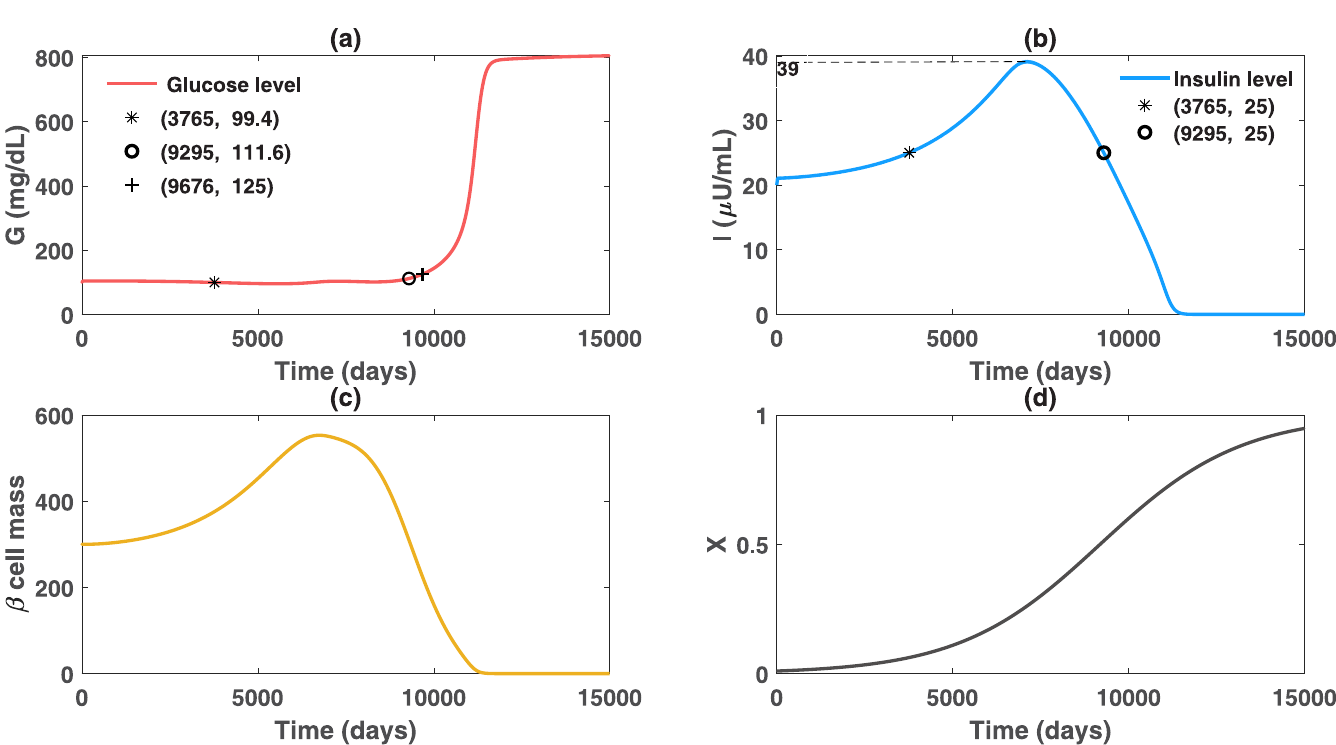
Fig 6. Dynamics of glucose, insulin and functional beta-cell mass for patient B with severe obesity ( X approaches 1 progressively). Patient B is assumed to have a lower insulin resistance level and less beta-cell hyperresponsiveness to the obesity-related factor than patient A does. Graph (b) shows the hyperinsulinemic stage of patient B lasts for 15.2 years, which is 3.3 years shorter than patient A does in Fig 2. The maximal insulin level he would develop is 39 μ U/ml, which is 27.6 μ U/ml lower than the highest level that patient A attains. During this hyperinsulinemic stage, the glucose levels can be well controlled beneath 111.6 mg/dl. Additionally, patient B would not step into the diabetic stage until day 9676, which is 11.5 years later than patient A does.